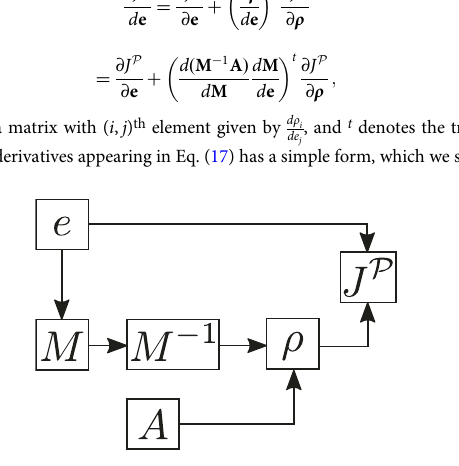
Fig. 6 Dependency graph for a discrete reaction-diffusion system with linear reaction kinetics. For linear kinetics, the reaction fl ux J P is proportional to the dot product of the enzyme pro fi le e and the substrate pro fi le ρ . The graphs shows that e affects J P both directly and indirectly. In fact, for a given e we have a reaction-diffusion operator M , whose inverse can be applied to the substrate source vector A to determine the substrate pro fi le ρ = M − 1 A . Thus to determine the total derivative dJ P d back-propagate the derivatives through these